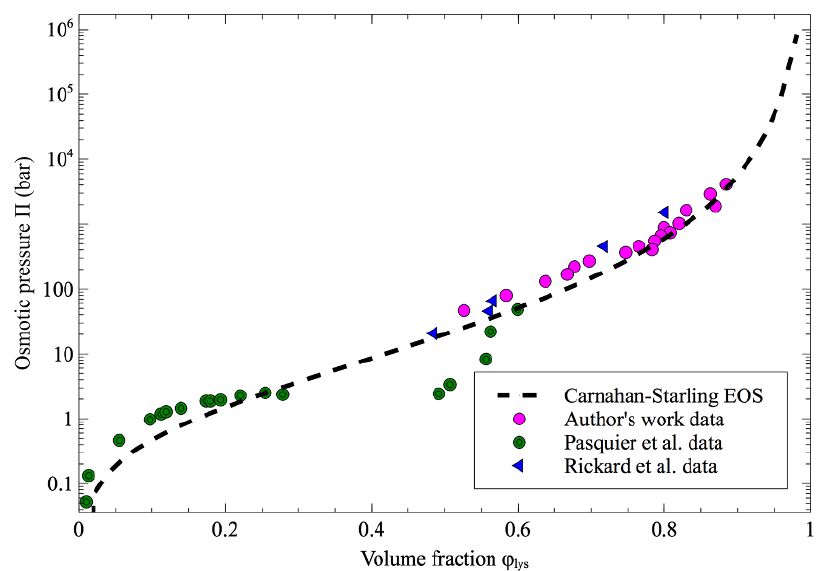
Figure 7. Osmotic pressure as a function of volume fraction of lysozyme. The author’s work data from this work (pink-filled circle) are compared with osmotic pressure values previously reported in the literature (green-bullseyes for data from Pasquier et al. [4], blue-filled triangle for data from Rickard [7] and the dash line for Carnahan – Starling approximation).